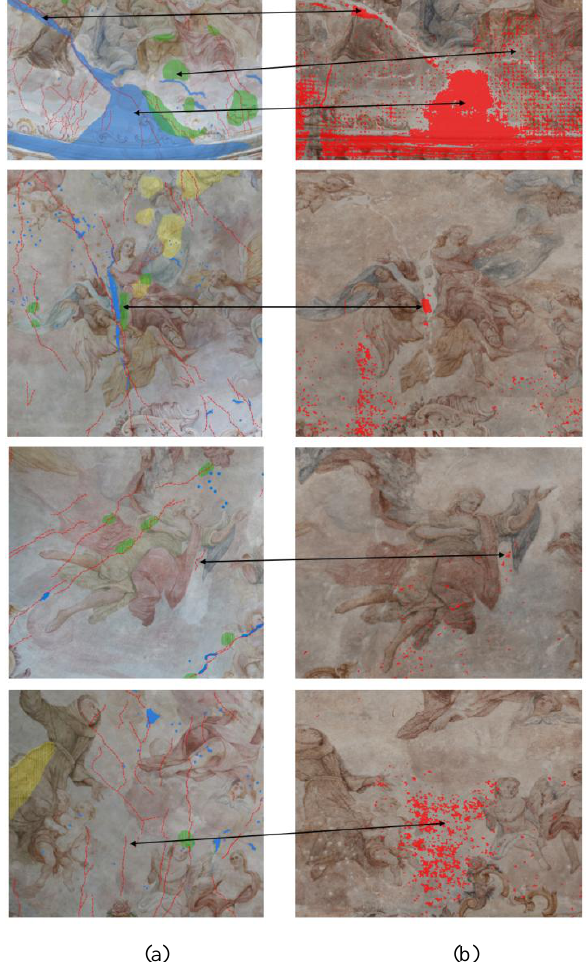
Figure 8 : Comparison of the damage map (a) and vector layer acquired from differential point clouds